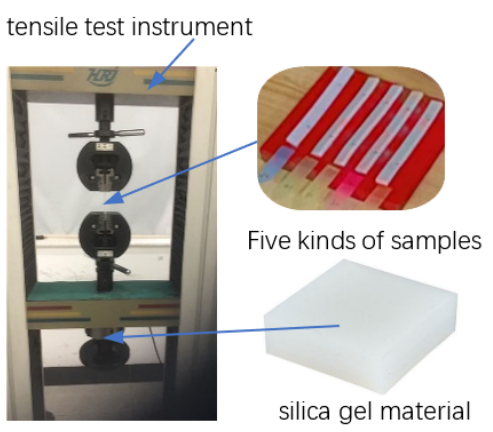
Figure 2. Tensile test of silica gel with different proportions of glass fiber.